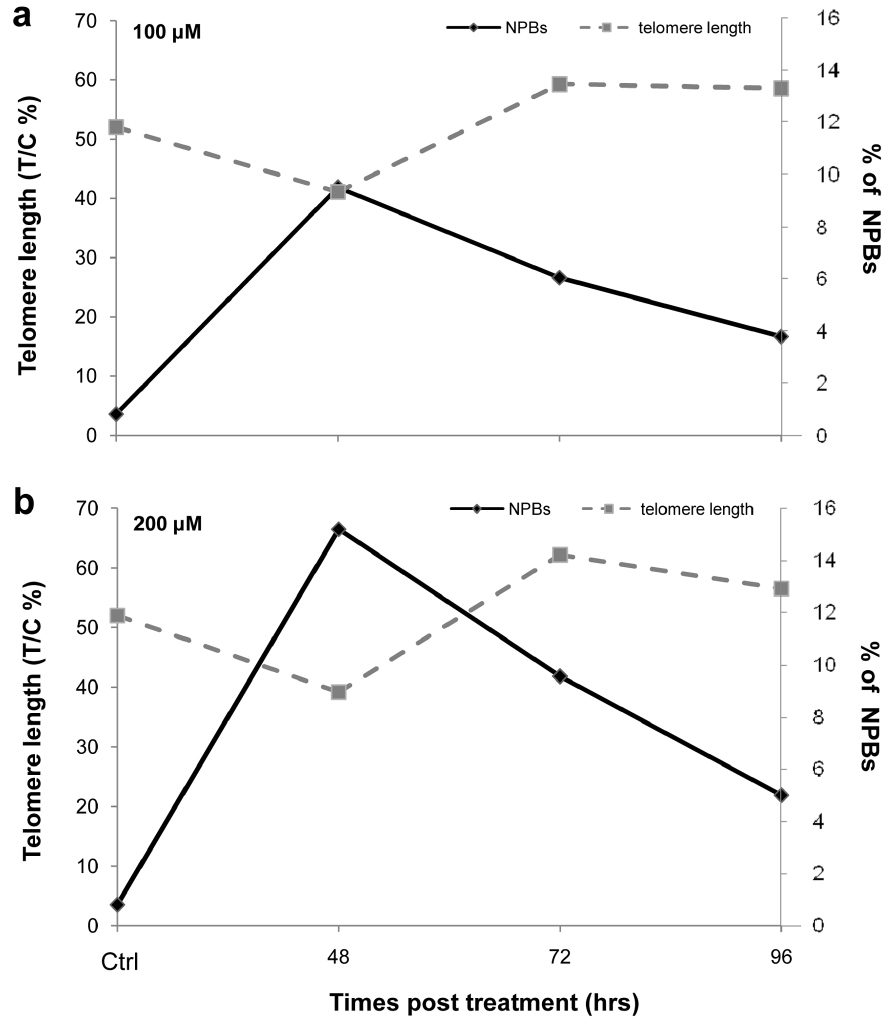
Figure 9. CIN-telomere length. The graphs indicate the relationship between telomere length, expressed as T/C%, and the % of NPBs in 1000 bi- nucleated cells at both doses (a) 100 m M; (b) 200 m M. For both doses, we observed a significant decrease of the T/C% and an increase of the % of NPBs 48 hrs after treatment. The other times revealed a restoration of telomere length to the control value and a decrease in the % of NPBs.